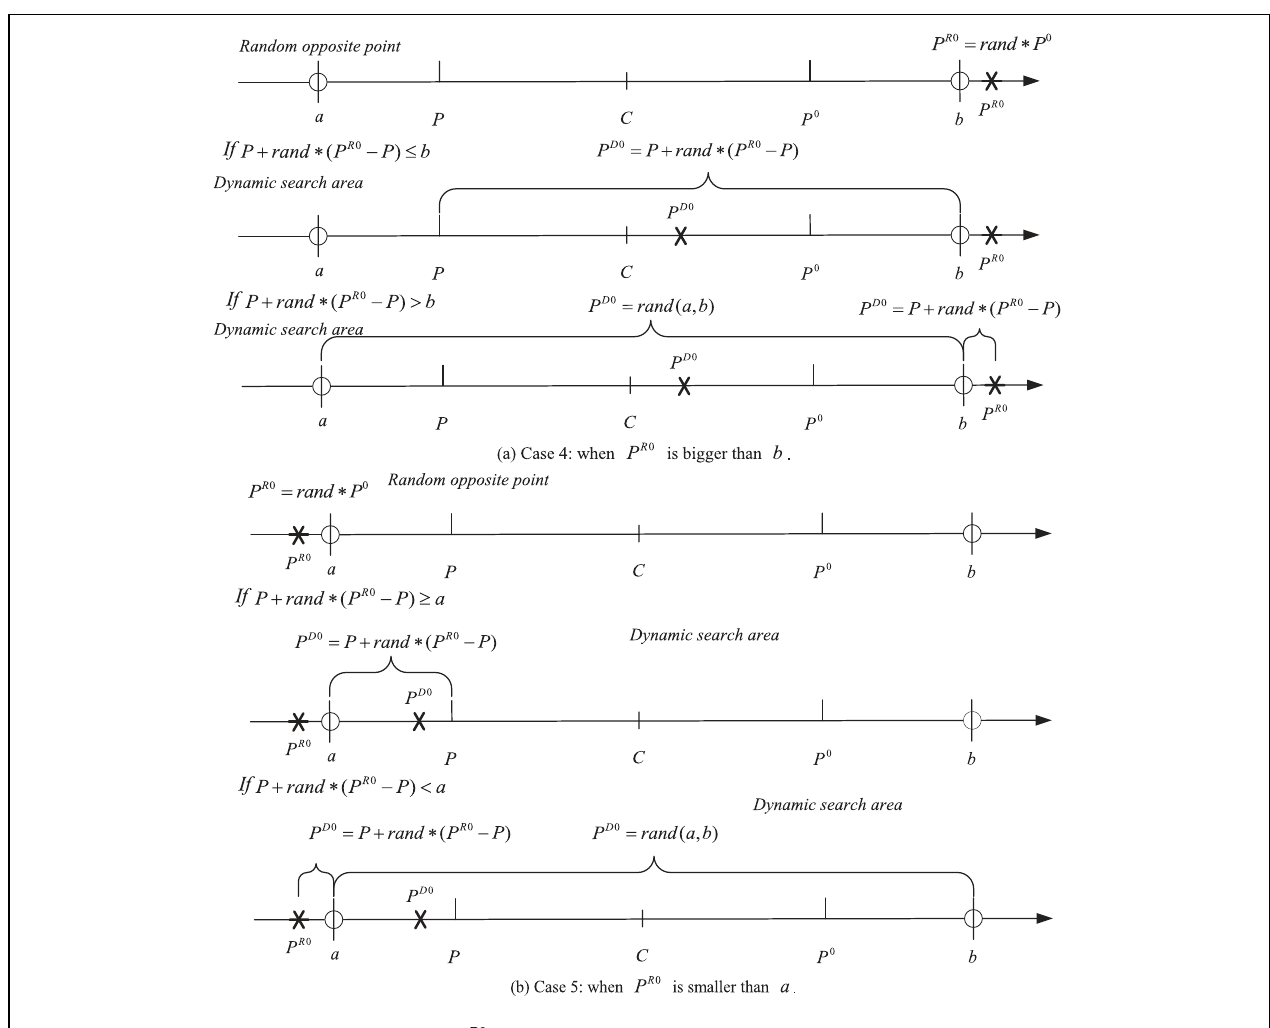
FIGURE 4 | DOL asymmetric dynamic search area when P R 0 ∉ ( a , b )